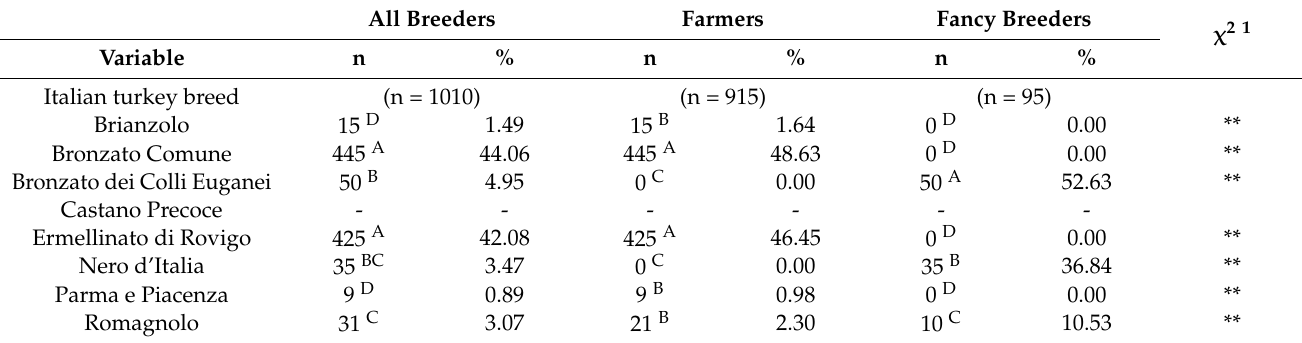
1 Chi square test for a single variable between the two breeder categories, i.e., within row compari- sons; significance levels: ** p < 0.01. A–D Observations with different superscripts within the column are significantly different ( χ 2 -test p < 0.01).